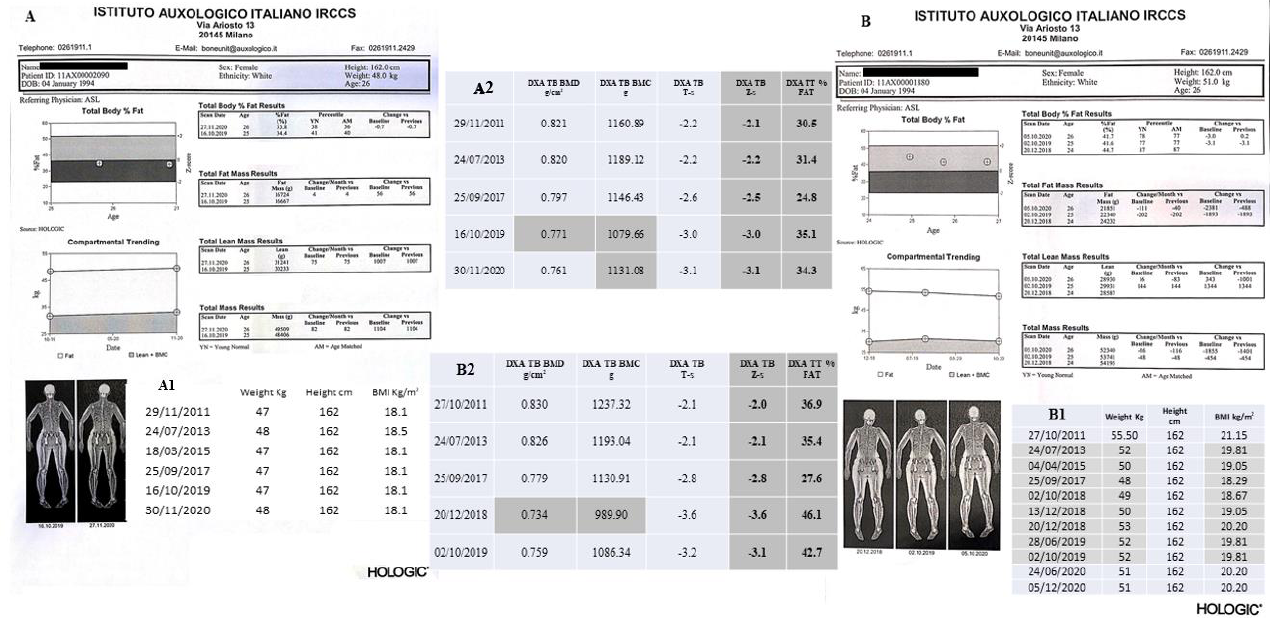
Figure 5. ( A ) II-1 Tw1 TB% fat composition results, 2019 vs. 2020. ( A1 ) reports anthropometric results from 2011 up to 2020, and ( A2 ) summarizes DXA TB parameters (BMD, BMC, T- and Z-scores, and total fat percentage) from 2011 up to 2020. ( B